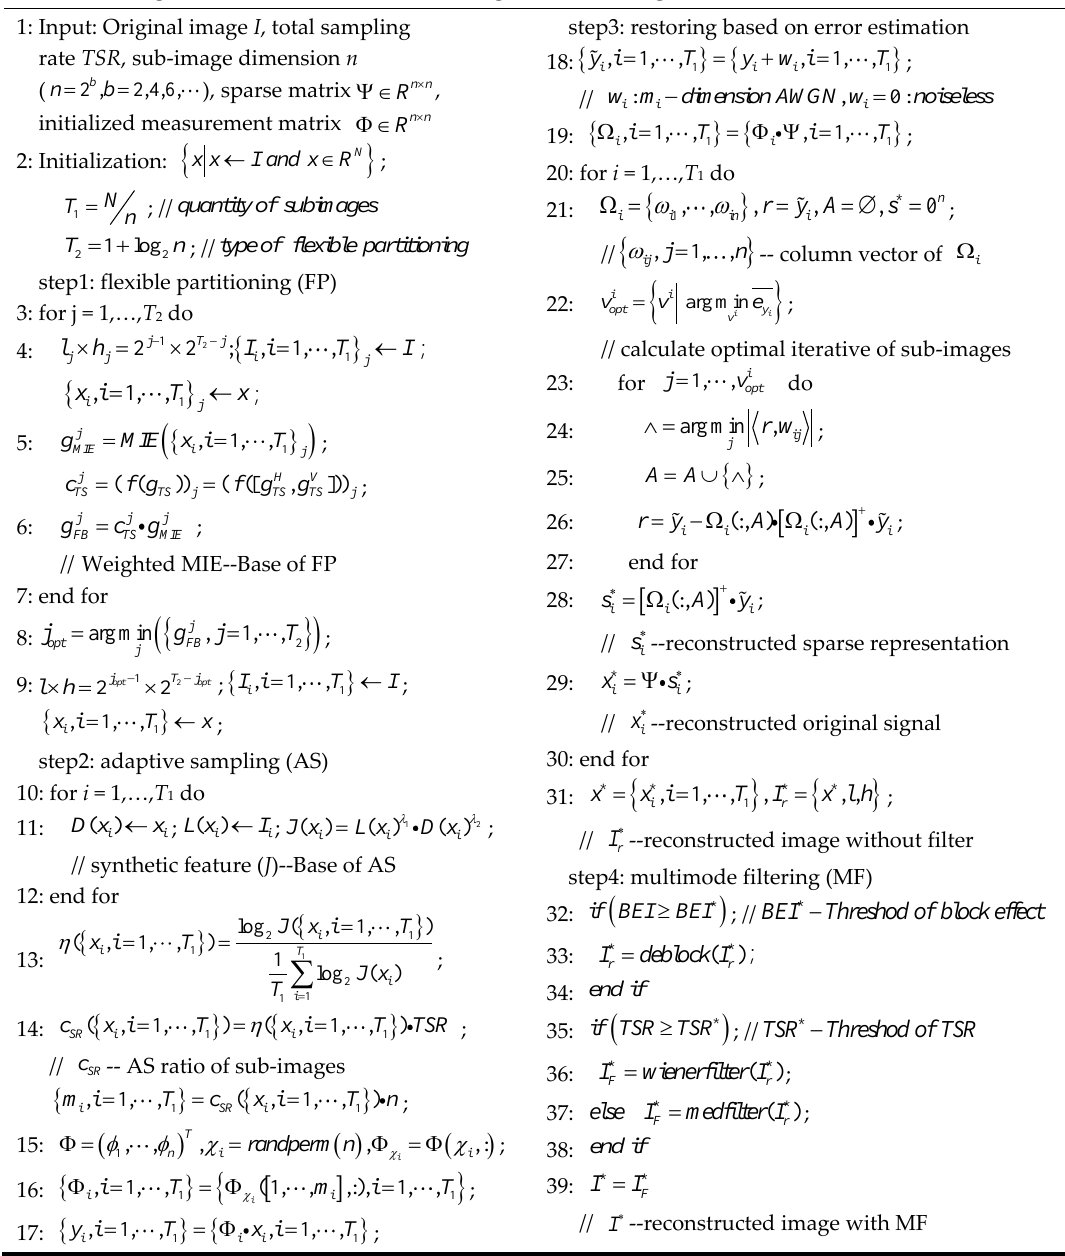
FE-ABCS Algorithm based on OMP (Orthogonal Matching